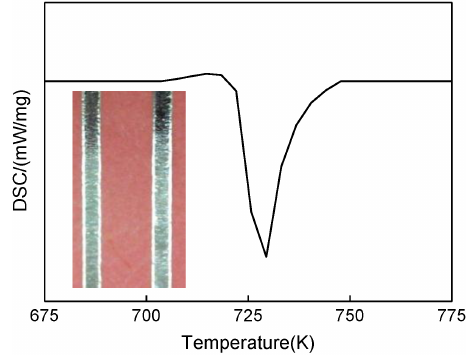
Figure 1. Differential scanning calorimeter (DSC) curve of the Cu 50 Zr 50 foil prepared by copper-mold rejecting process.